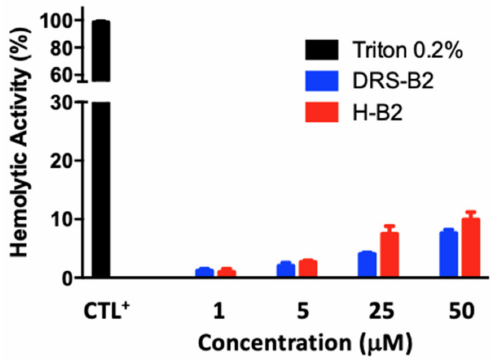
Figure 3. Hemolytic activity of DRS-B2 and H-B2 on human erythrocytes. Human erythrocytes were cultured with different concentrations of DRS-B2 or H-B2 for 1 h at 37 ◦ C. Cells treated with 0.2% Triton X100 were used as a positive control (CTL + ) and correspond to 100% of the hemolytic activity used as reference.